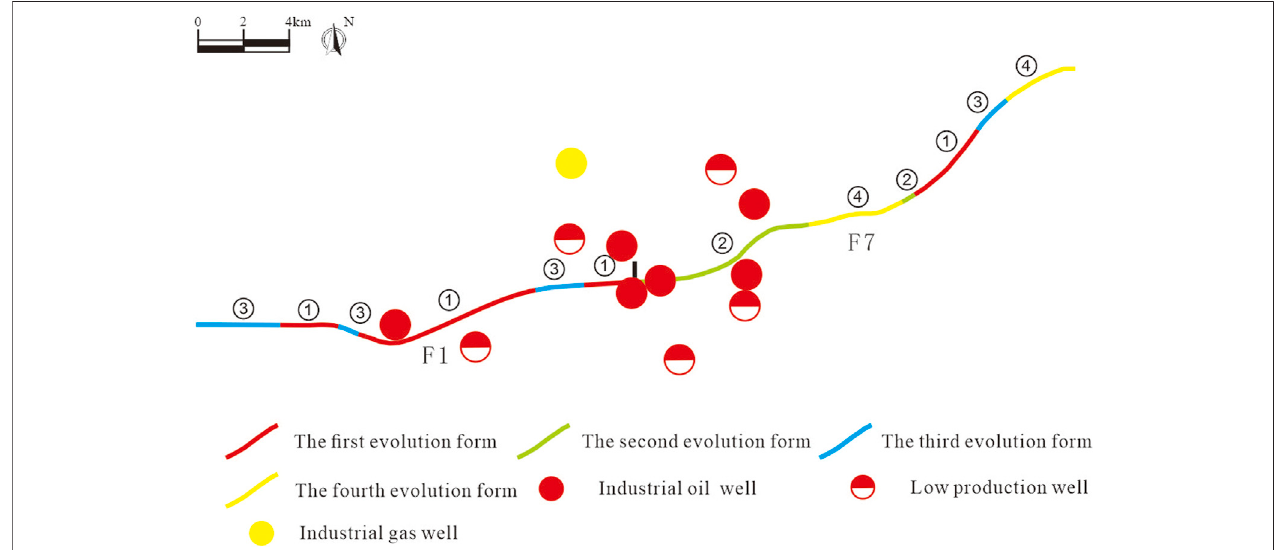
FIGURE11| Theevolutionpattern andoilandgasdistribution diagram ofthefavorablepositionfortransportingoilandgasintheinner sourcefaultcon fi guration in the lower member of the middle and lower sub-member of Es3 in the southwest of Jiuzhou fault.